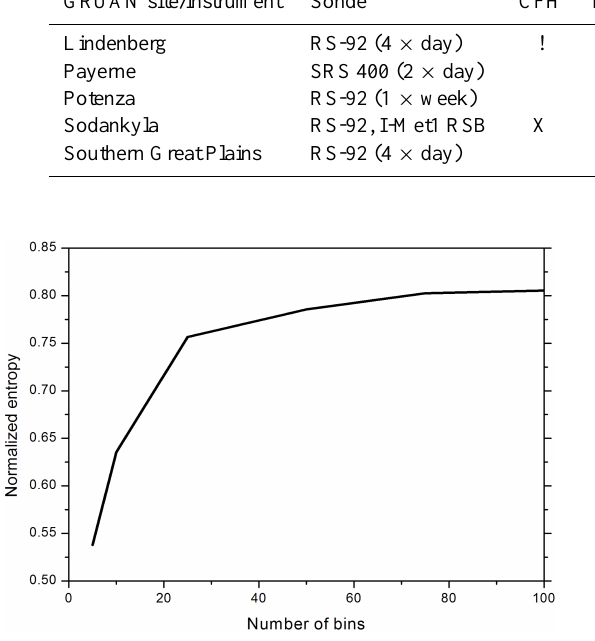
Figure 1. Entropy as a function of the number of bins used to build the histogram for the Payerne